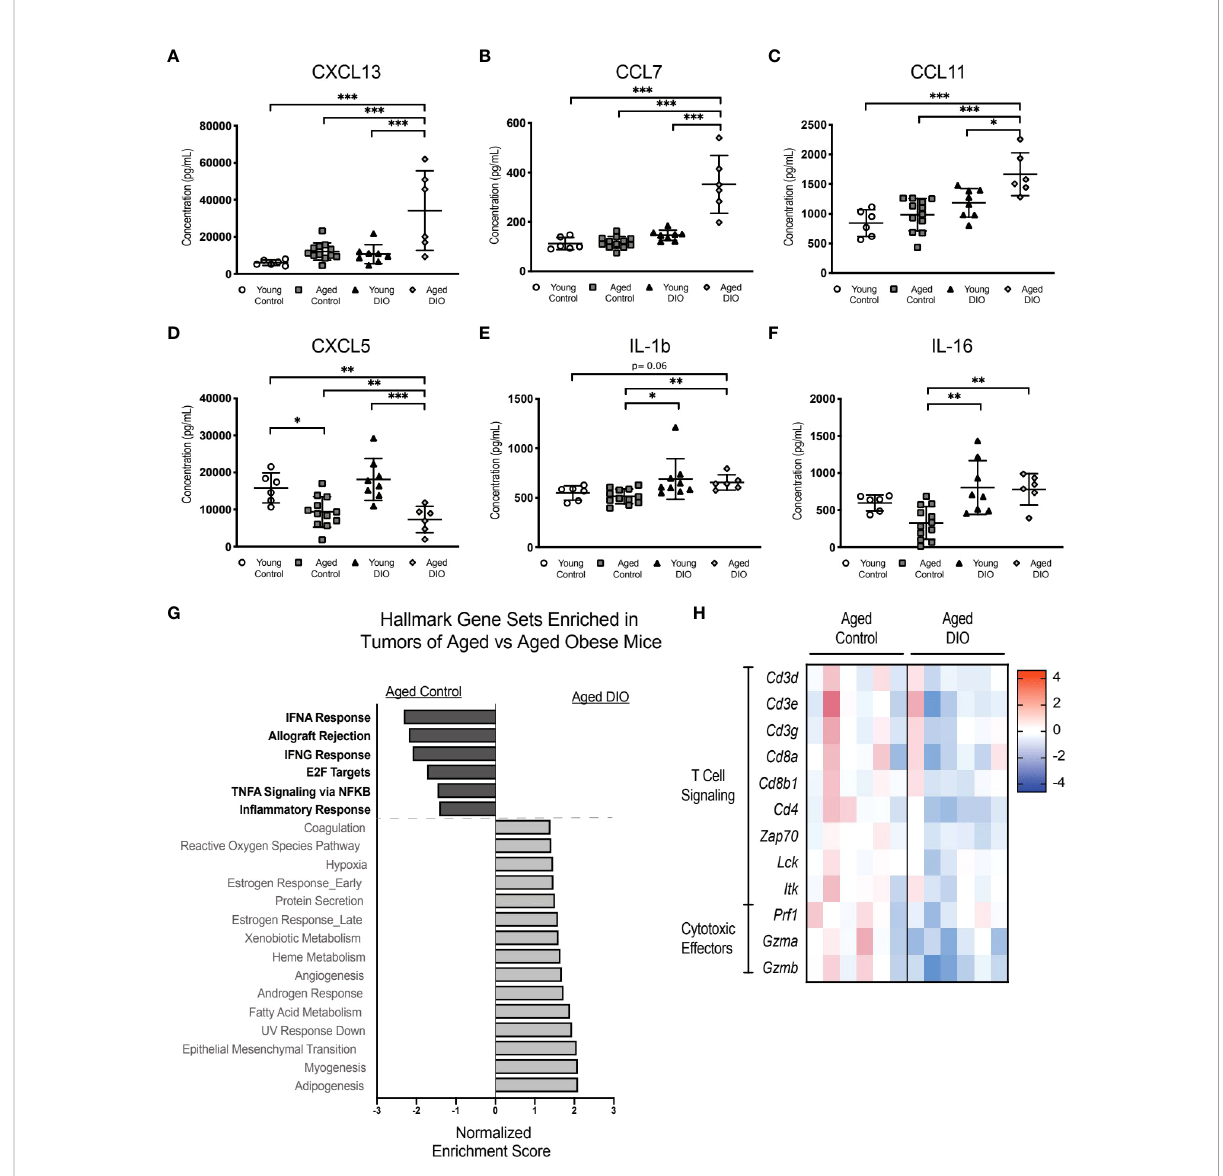
FIGURE 6 The combination of advanced age and DIO exacerbates tumor immune suppression. (A-F) Serum cytokines measured in serum collected prior to tumor inoculation. (G) Hallmark gene sets commonly enriched and underrepresented in mammary tumor of aged DIO versus aged control mice determined using gene set enrichment analysis (GSEA). (H) Heat map of select leading edge genes. Data presented as mean ± SD. Differences across groups analyzed using one-way ANOVA and Tukey post hoc test, unless otherwise speci fi ed. Signi fi cantly enriched gene sets de fi ned as FDR q-value <0.05. Asterisks indicate differences in signi fi cance. *p < 0.05, **p < 0.01, ***p <